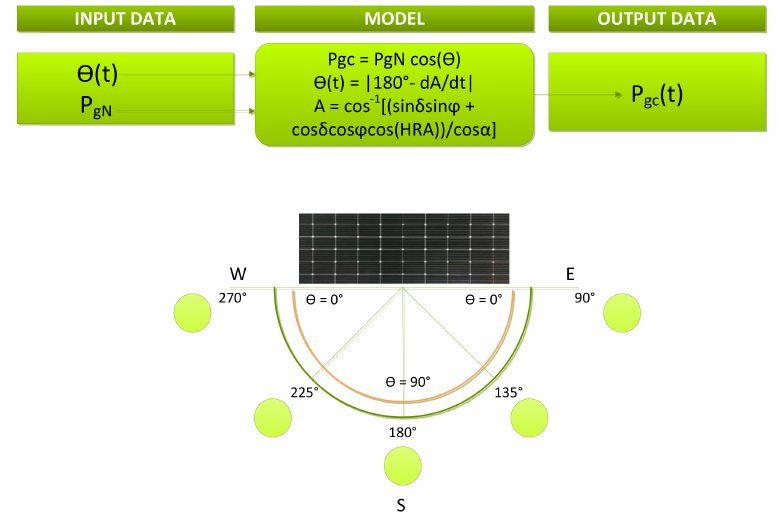
Figure 3. Mapping the movement of the sun during the day to the PV power– P gc ( t ).